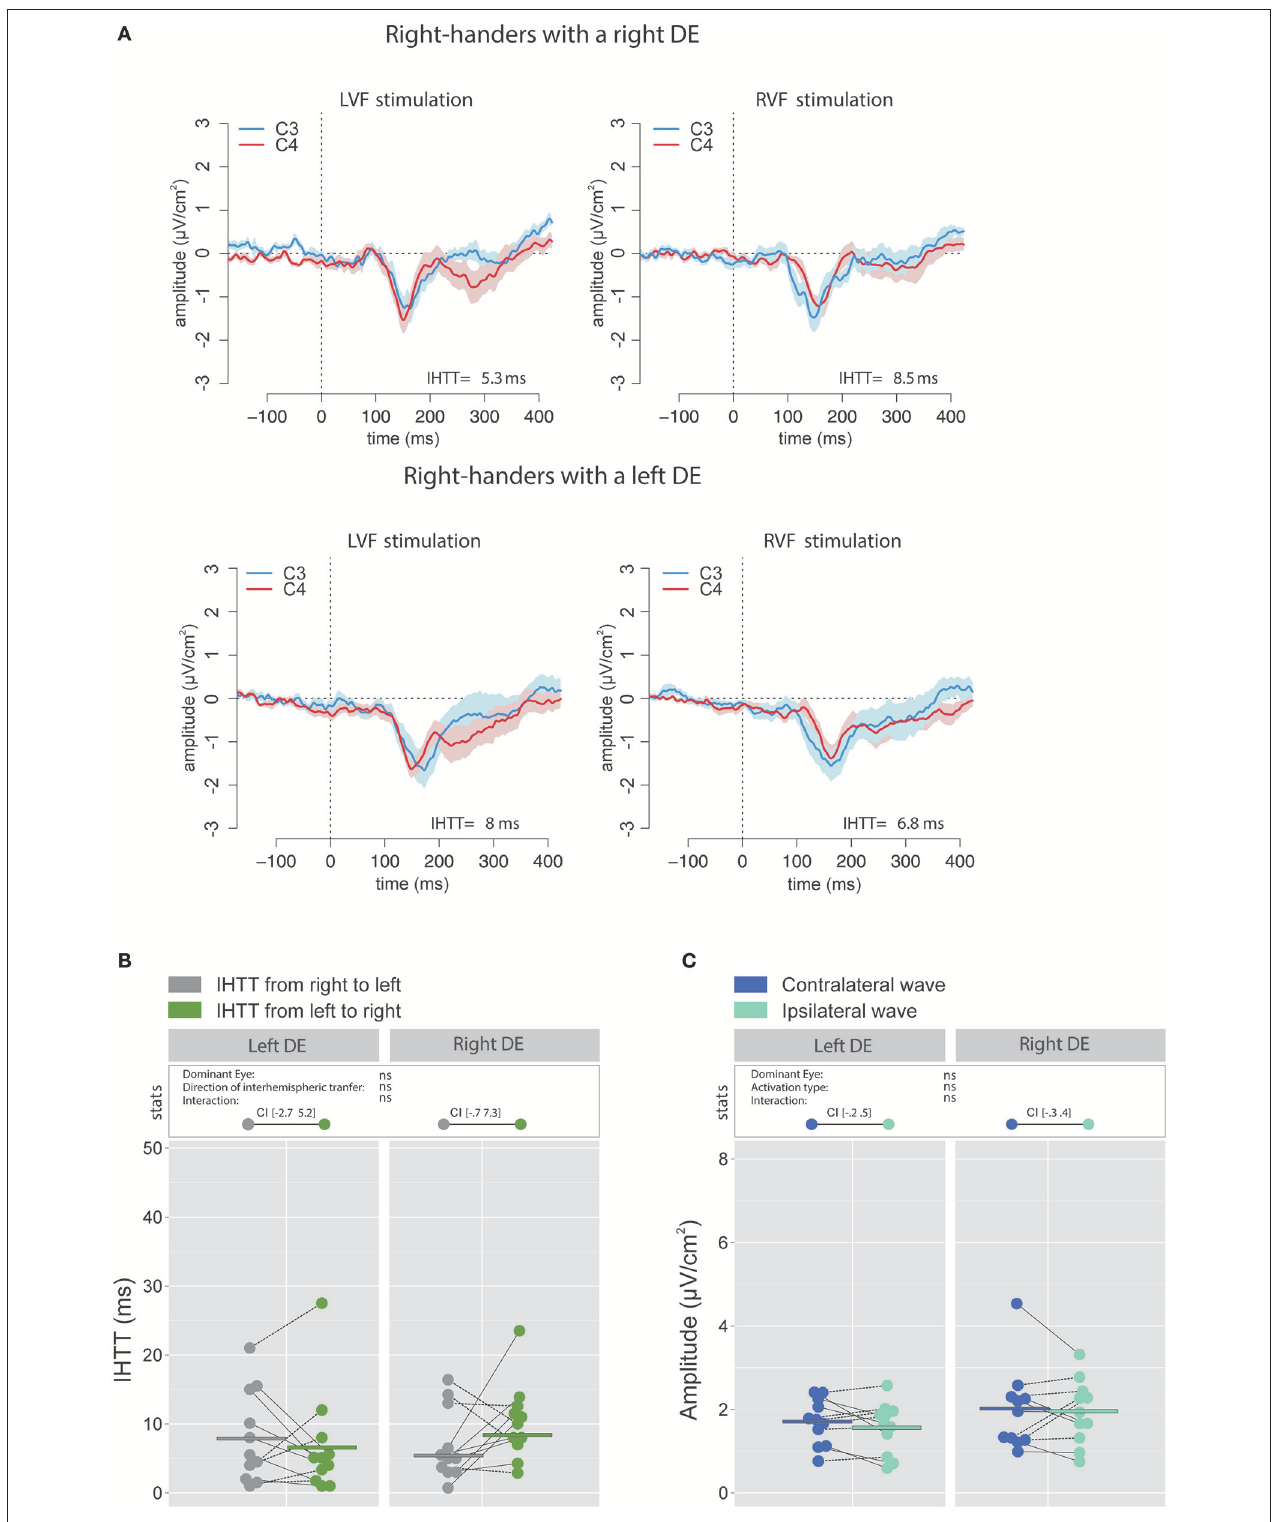
FIGURE 5 | Waveforms and average results computed over central sites after Laplacian transformation in right-handers. (A) Grand average CSD waveforms recorded over C3 (blue waves) and C4 (red waves) electrodes in the two experimental conditions (LVF or RVF stimulation). Shading blue and red areas represent the